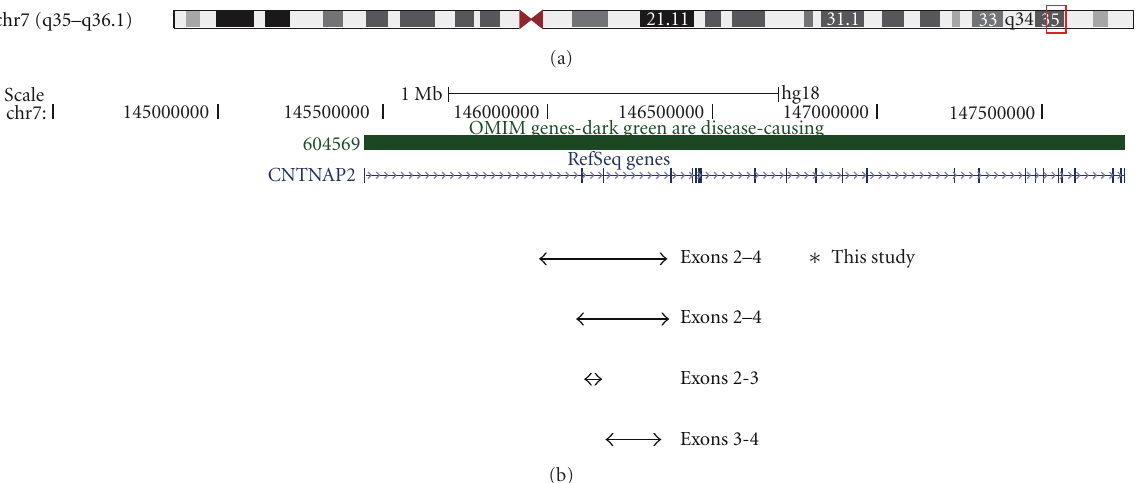
Figure 1: Schematic of the chromosome 7 region encompassing the CNTNAP2 gene. (a) shows an ideogram of chromosome 7, together with the location of the CNTNAP2 gene. (b) shows the exonic organisation of the CNTNAP2 gene and the location and extent of the deletion detected in the proband (indicated by an asterisk), his brother and his mother, together with deletions reported by Gregor et al. [15] (patients reported as C5 and C6 with deletions of exons 2-3 and 3-4, resp.), and Me ff ord et al. [16] (patient reported as K034 with a deletion of exons 2–4; coordinates taken from Figure 2 of this publication), which lie in the same region of the CNTNAP2 gene. The images presented here are taken from the UCSC genome browser (http://genome.ucsc.edu/).